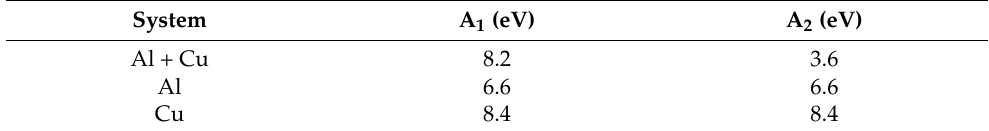
Figure 12. Results of ANN training: MD and ANN strain dependencies of ( a ) shear stress 𝜏 and ( c ) pressure 𝑃 , and ( b , d ) the corresponding correlation plots.